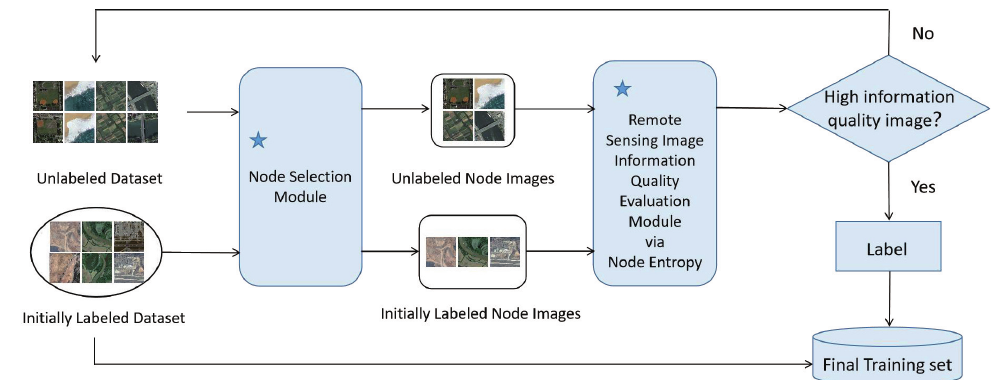
Figure 1. Method overview. Combine the remote sensing image information quality evaluation method via node entropy with the active learning image selection strategy. The node selection module selects the node images in the initially labeled dataset and the unlabeled dataset. The remote sensing image information quality evaluation module evaluates the information quality of the node images according to the node entropy in the unlabeled datasets. Initially, labeled datasets and high information quality node images from unlabeled datasets are selected to form the final training set. The marking parts of the pentagram are the key modules of this